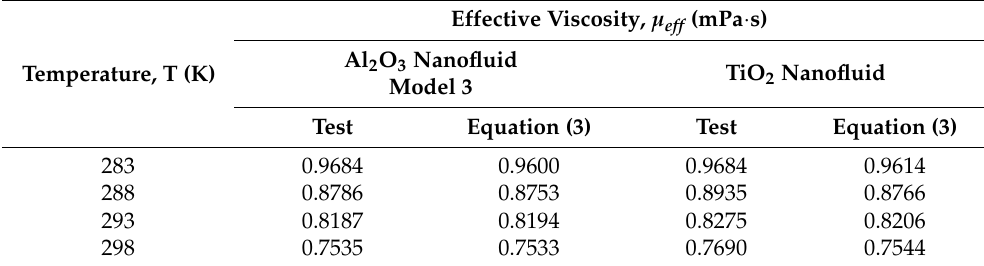
Table 5. Effective viscosity ( µ ef f ) of Al 2 O 3 and TiO 2 nanofluids (0.1 v%) with temperature.